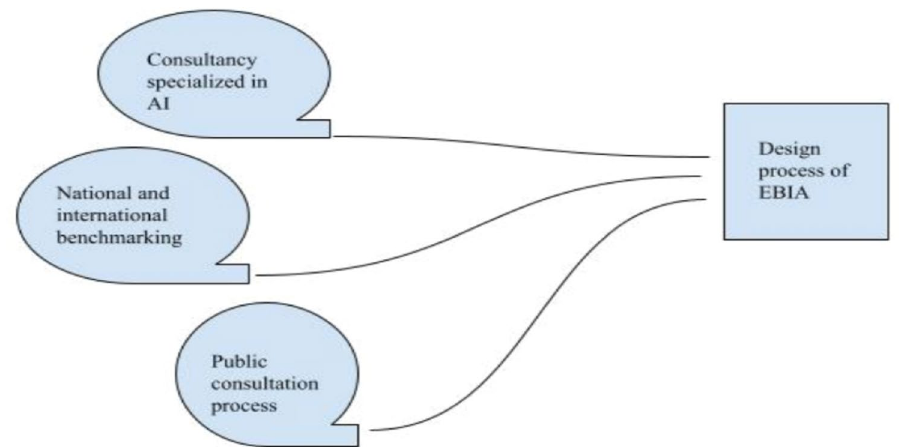
Fig. 1 Design process of EBIA. Source: elaborated by